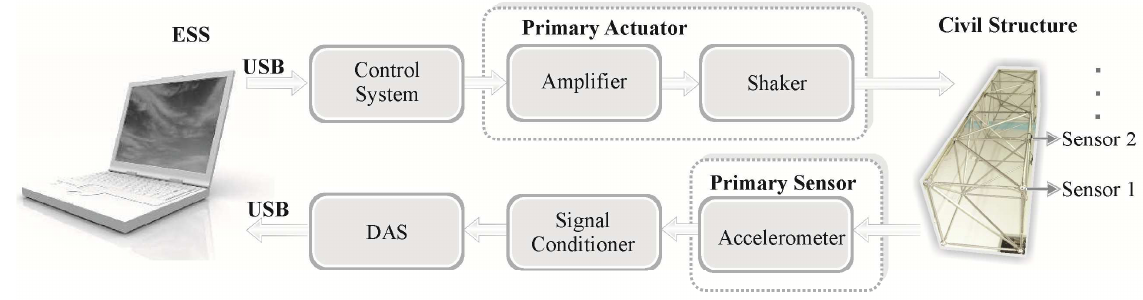
Figure 2. Proposed methodology flow diagram. 3